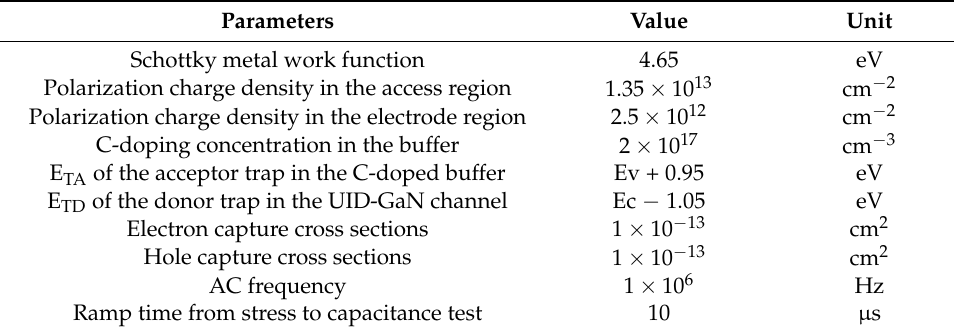
Table 1. Parameters utilized in the